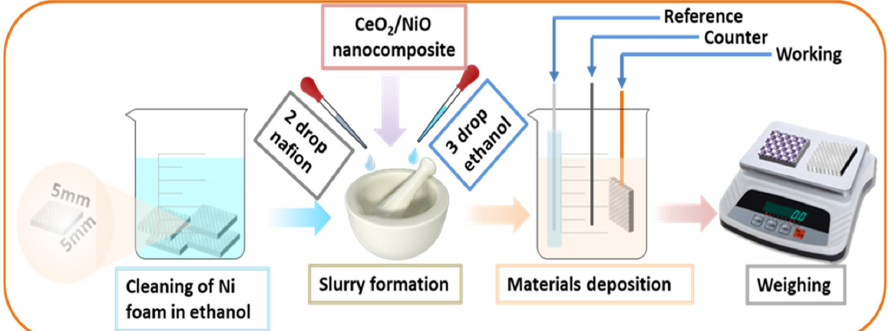
Figure 1. A schematic of electrode synthesis.